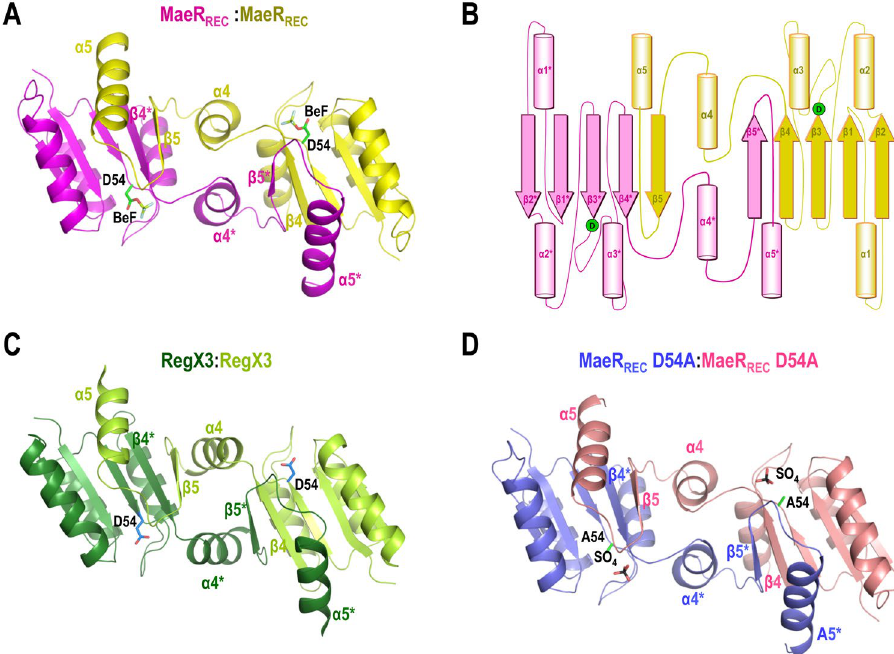
Figure 4. Crystal structure of MaeR REC wild-type and D54A mutant. ( A ) Cartoon representation of the dimeric MaeR REC wild-type structure highlighting the structural elements involved in the swapped dimerization surface (one monomer in magenta, the other in yellow) as well as the catalytic Asp bound to BeF 3 − (in green). ( B ) Schematic representation of the MaeR dimer showing the structural elements involved in the swapped dimerization. ( C ) Cartoon representation of RegX3 REC domain (PDB: 2OQR) which presents the same swapped dimerization architecture as MaeR. ( D ) Cartoon representation of the dimeric MaeR REC -D54A structure that shows the same swapped dimer organization (one monomer in blue, the other in pink) as MaeR. The Ala residue replacing the phosphoacceptor Asp and the sulfate ion occupying the active site are highlighted in sticks.